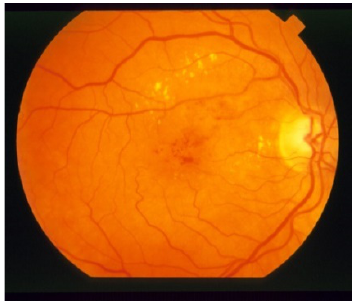
Figure 2. Retinal Vein Occlusion